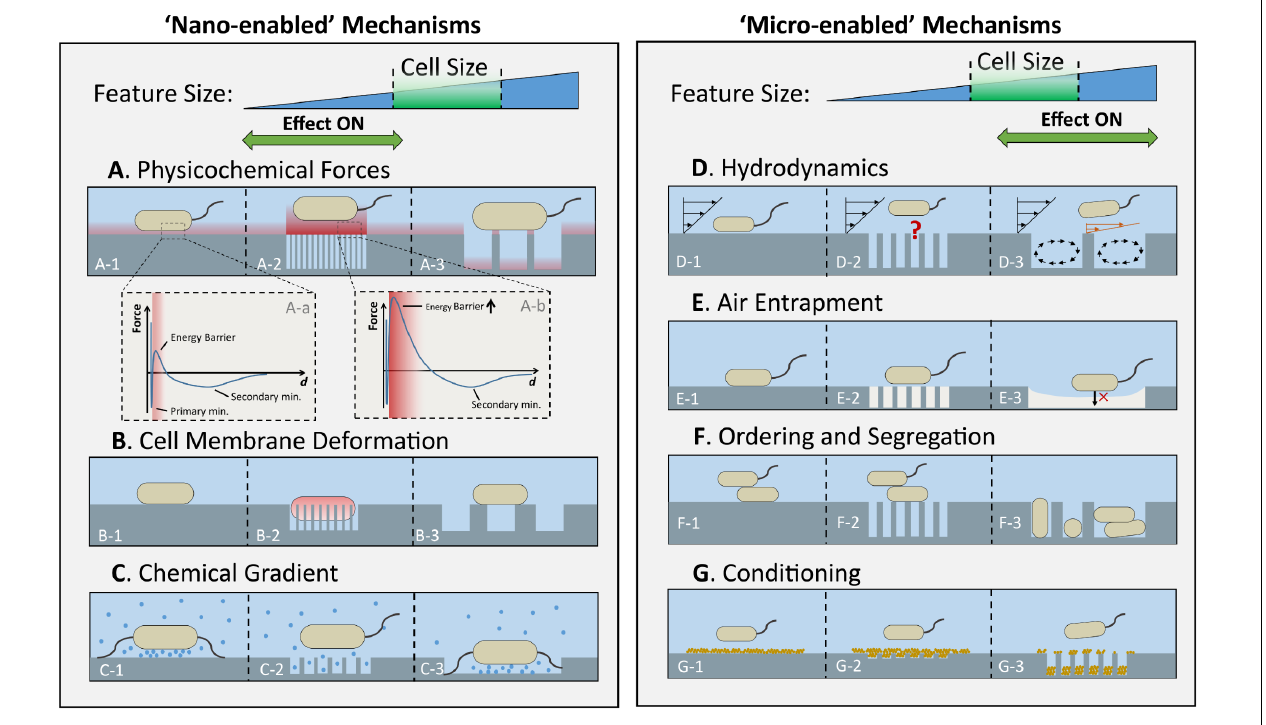
FIGURE 2 | Scale-dependent effects of surface topography on various factors that influence initial bacterial attachment. The anti-attachment effects of physicochemical forces (A) , cell membrane deformation (B) , and chemical gradient (C) , are enhanced by surfaces with features much smaller than bacterial cells (left panel), whereas the anti-attachment effects of hydrodynamics (D) , air entrapment by topographic features (E) , and cell ordering and segregation (F) are enhanced by the topographies with feature sizes larger than or comparable to bacterial cells (right panel). Within each row, from left to right, the scenarios for a flat surface, a surface with nanoscale, and a surface with microscale topography are illustrated. The typical force-distance profile for a flat and a nanoporous surface, respectively, are illustrated in A-a and A-b. Conditioning films (G) complicate attachment trends by altering the chemistry and topography of the neat surface.